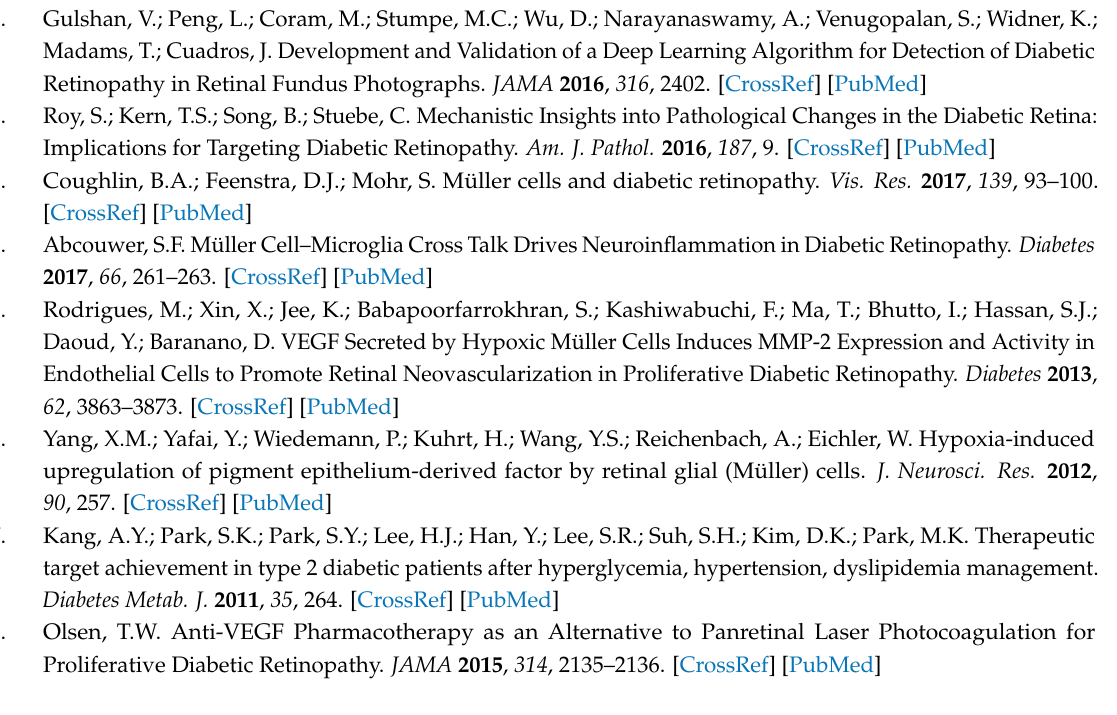
Figure S1: 60 mM HG preconditioning exerted no osmotic toxicity on rMC-1